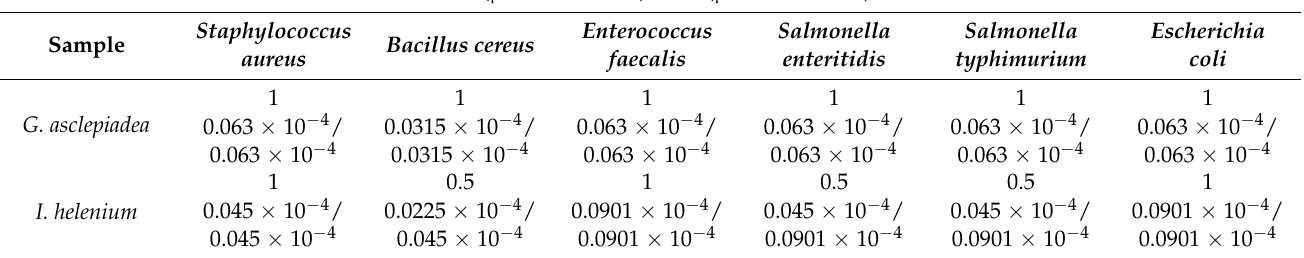
Table 5. Antibacterial activity of G. asclepiadea and I. helenium root ethanolic extracts (broth microdilu- tion